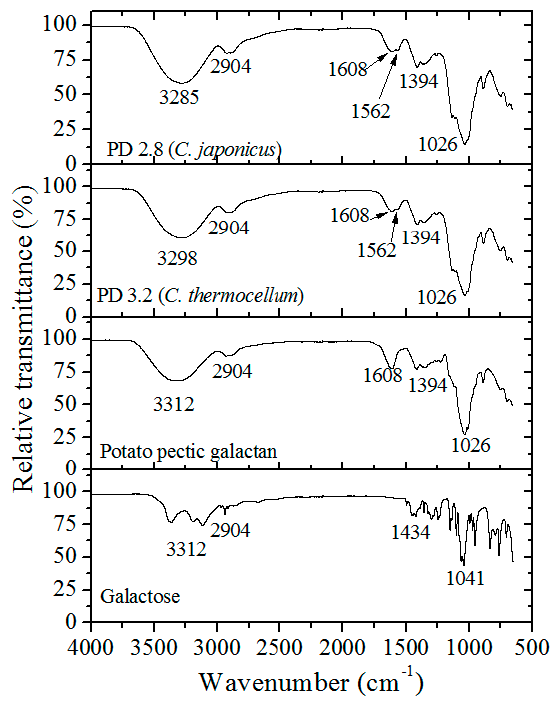
Figure 6. Fourier transform infrared ( FT-IR) spectra of galactose standard, potato galactan, and PGOs produced by C. japonicus and C. thermocellum enzyme. Materials 2019 , 12 , x FOR PEER REVIEW 12 of 14